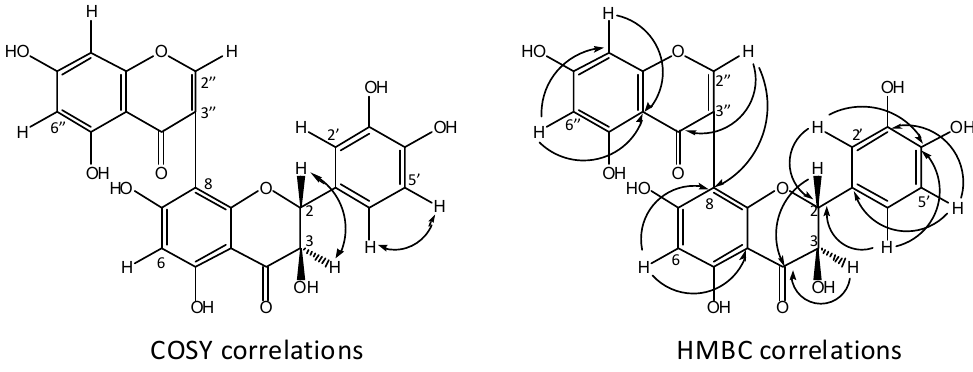
Figure 2. Compound 1 , COSY and HMBC